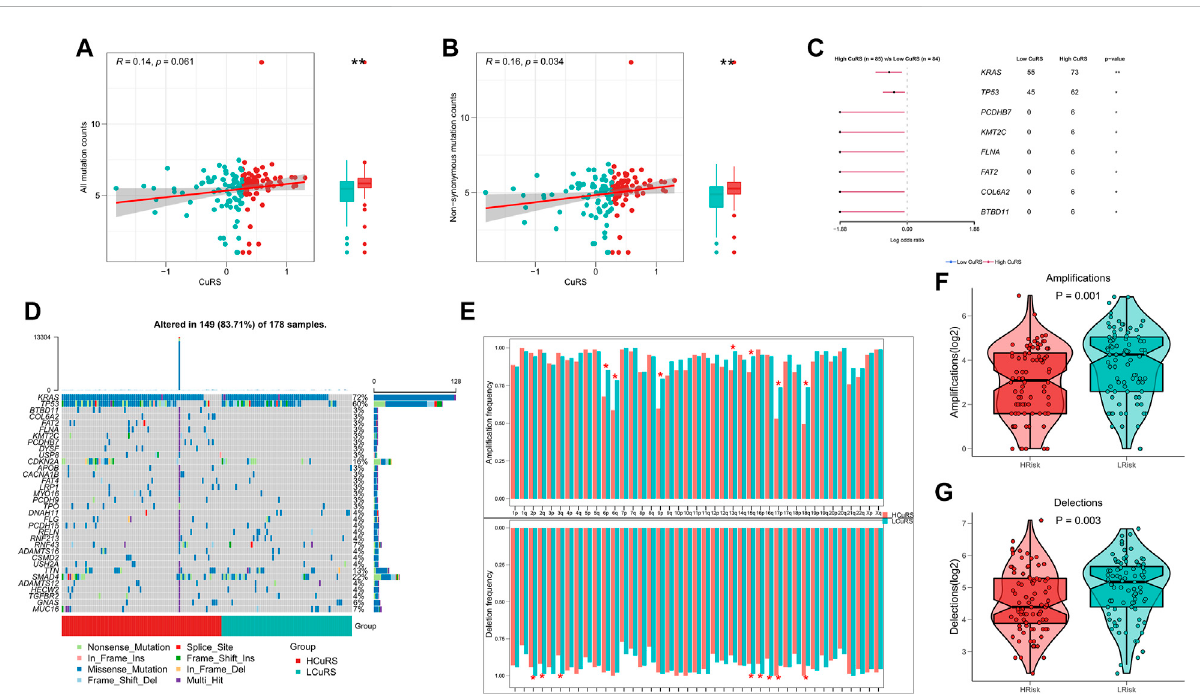
FIGURE 6 Genomic variation landscape for the CuRS model. (A) Correlation between CuRS and all types of mutation burdens; (B) Correlation between CuRS and non-synonymous mutationburden; (C) Forest plotshowing signi fi cant differentially mutant genes (DMGs) betweengroups; (D) Oncoplot of DMGs between groups; (E) Bar chart showing CNV events on different chromosome arms in high- and low-CuRS groups (* p < 0.05); (F) Box plot showing the differences in chromosome ampli fi cation numbers between high- and low-CuRS groups; (G) Box plot showing the differences in chromosome deletion numbers between high- and low-CuRS